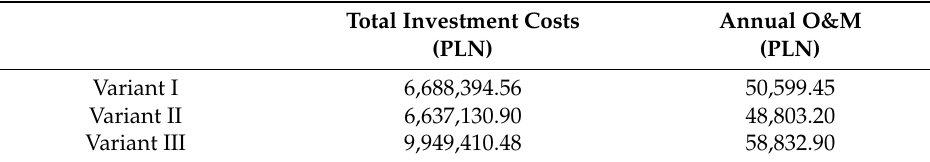
Table 1. Assumed preliminary investment and annual O&M (operation and maintenance) costs for each studied